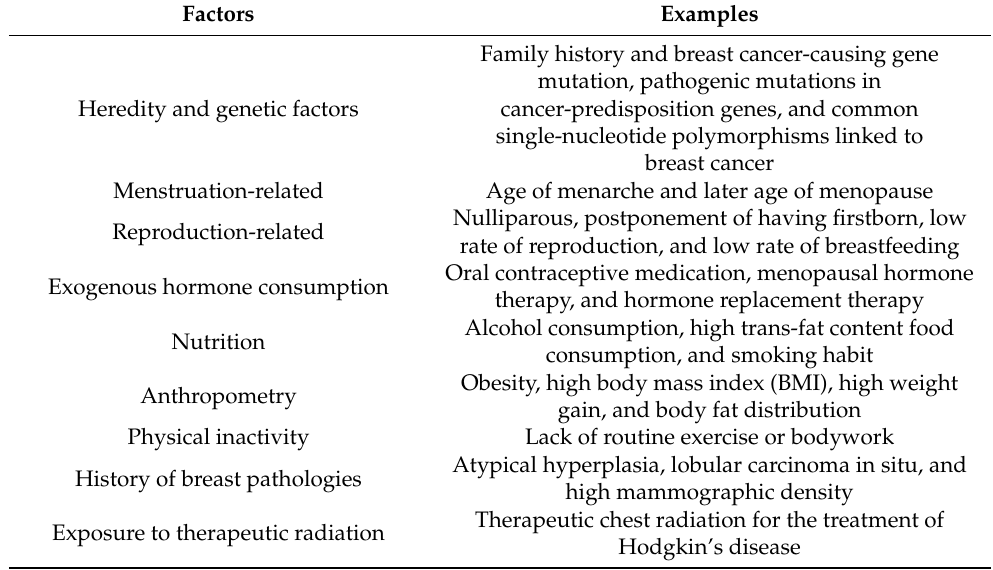
Figure 1. A statistical figure of the number of new breast cancer cases and mortality rate in the female population for the years 2008 and 2020 referring to GLOBOCAN estimated data for years 2008 and 2020 [2,3]. Table 1. Potential factors that increase the chances of obtaining breast cancer with